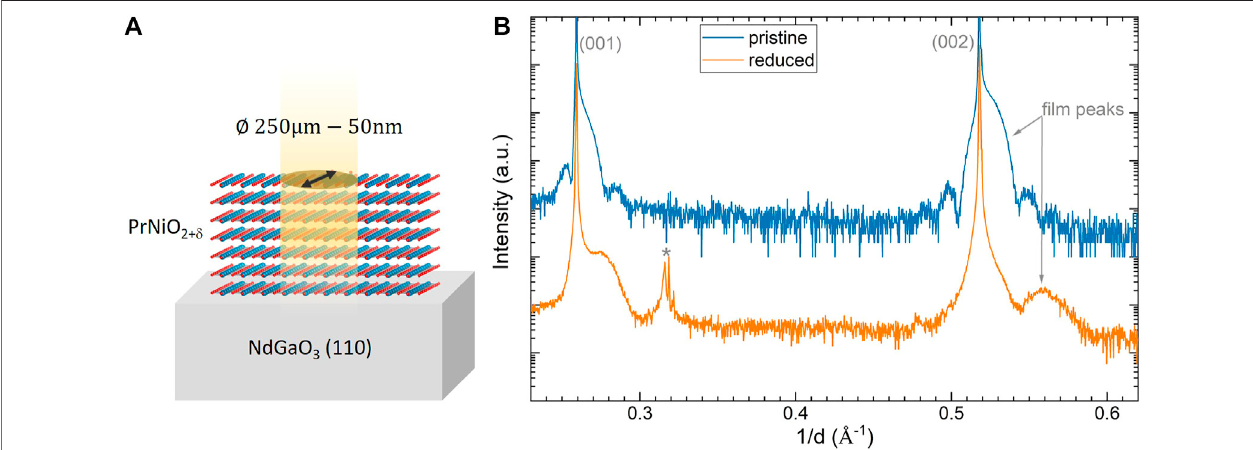
FIGURE 1 | (A) Sketch of the PrNiO 2+ δ thin fi lm on a NdGaO 3 substrate, indicating the large variation of the soft x-ray beam diameter used to investigate its lateral chemical homogeneity. (B) Hard x-ray diffraction around the (001) and (002) NdGaO 3 substrate re fl ection for the pristine (blue) and the 12 h at 250 ° C reduced (orange) sample. The fi lm peaks close to the (002) substrate peak are indicated and the star marks a peak arising from the sample